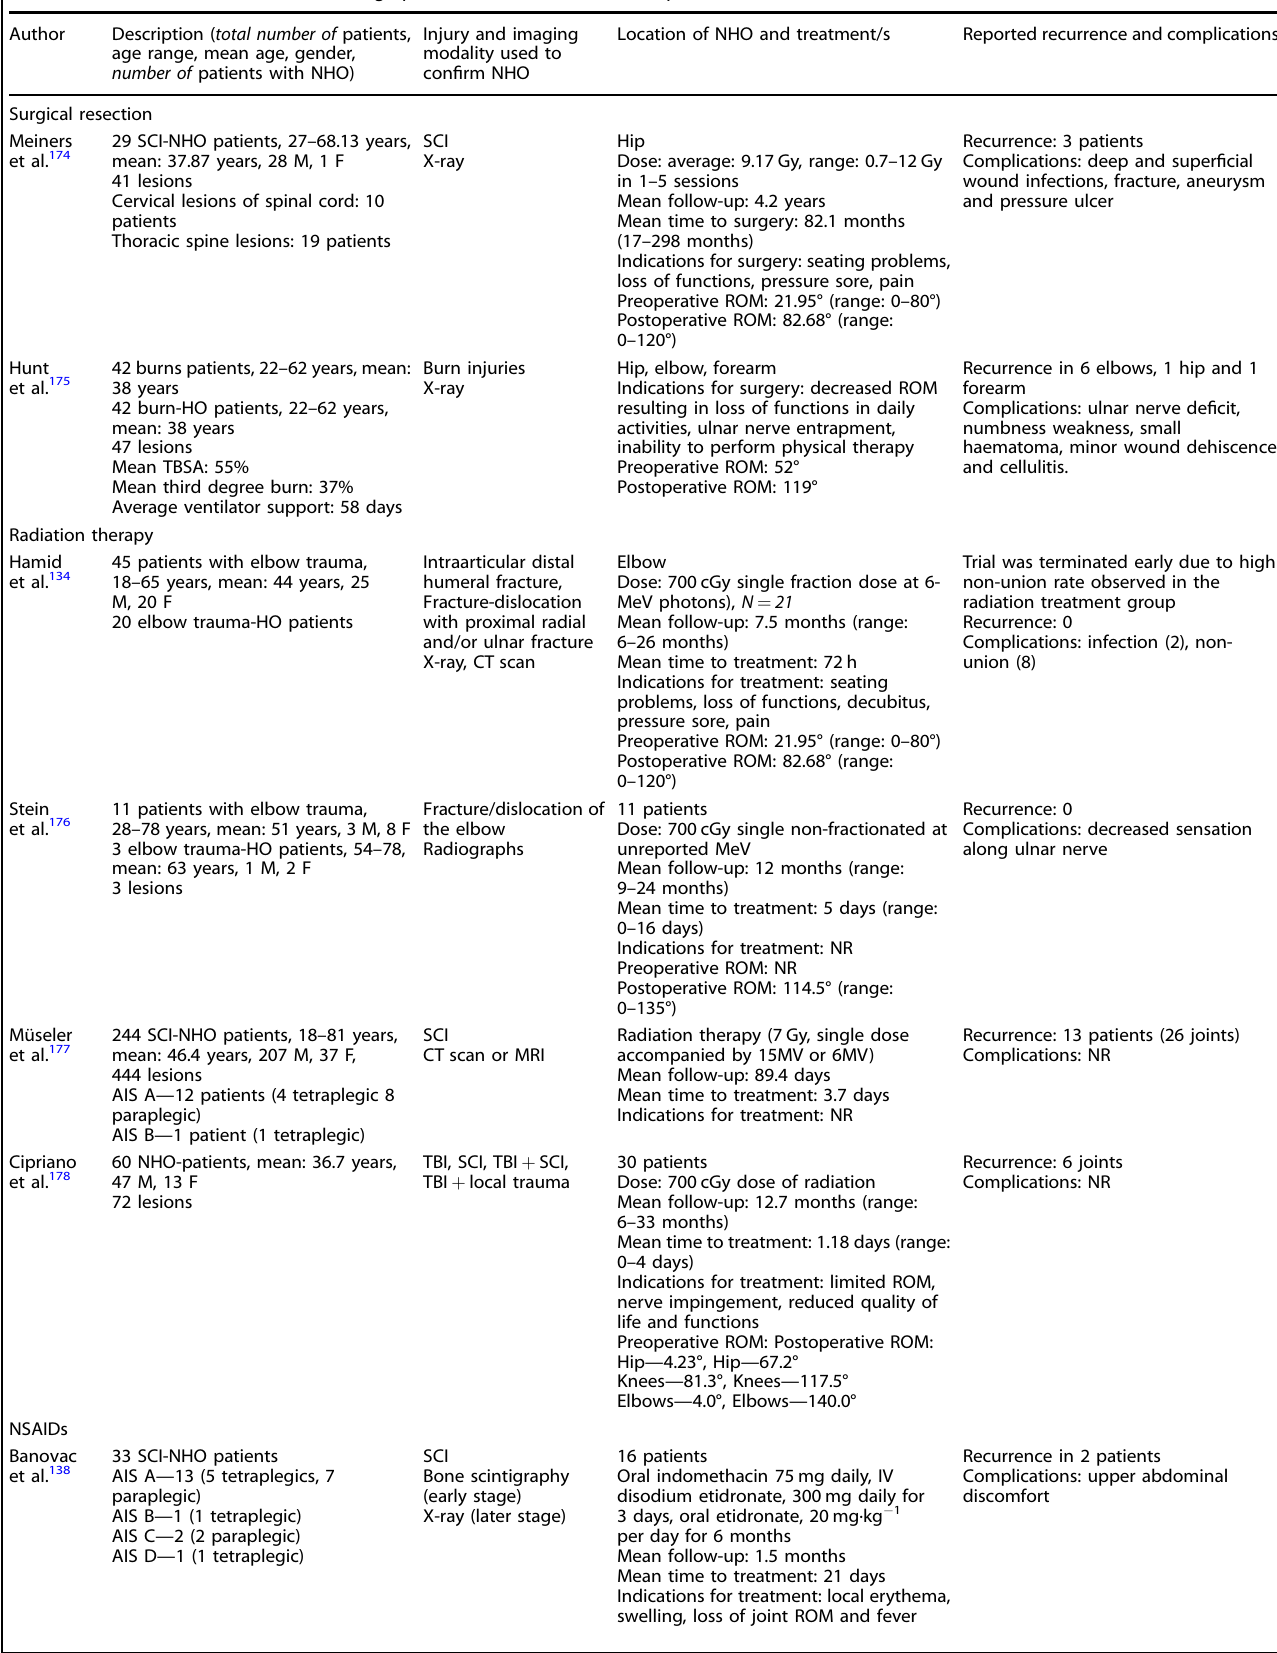
Table 2. Treatments for clinical and radiographical evidence of HO/NHO reported across literature